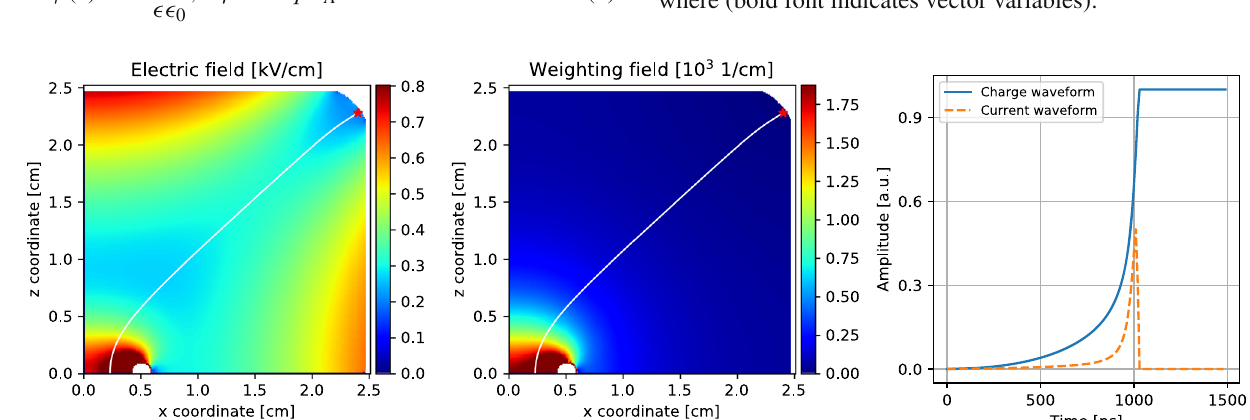
Fig. 13 Simulated electric field (left panel), weighting field (central panel) and an example of a pulse induced in the detector. The induced charge (blue continuous line in the right panel) corresponds to the tra- jectory marked with the white lines on the left and the central pan-